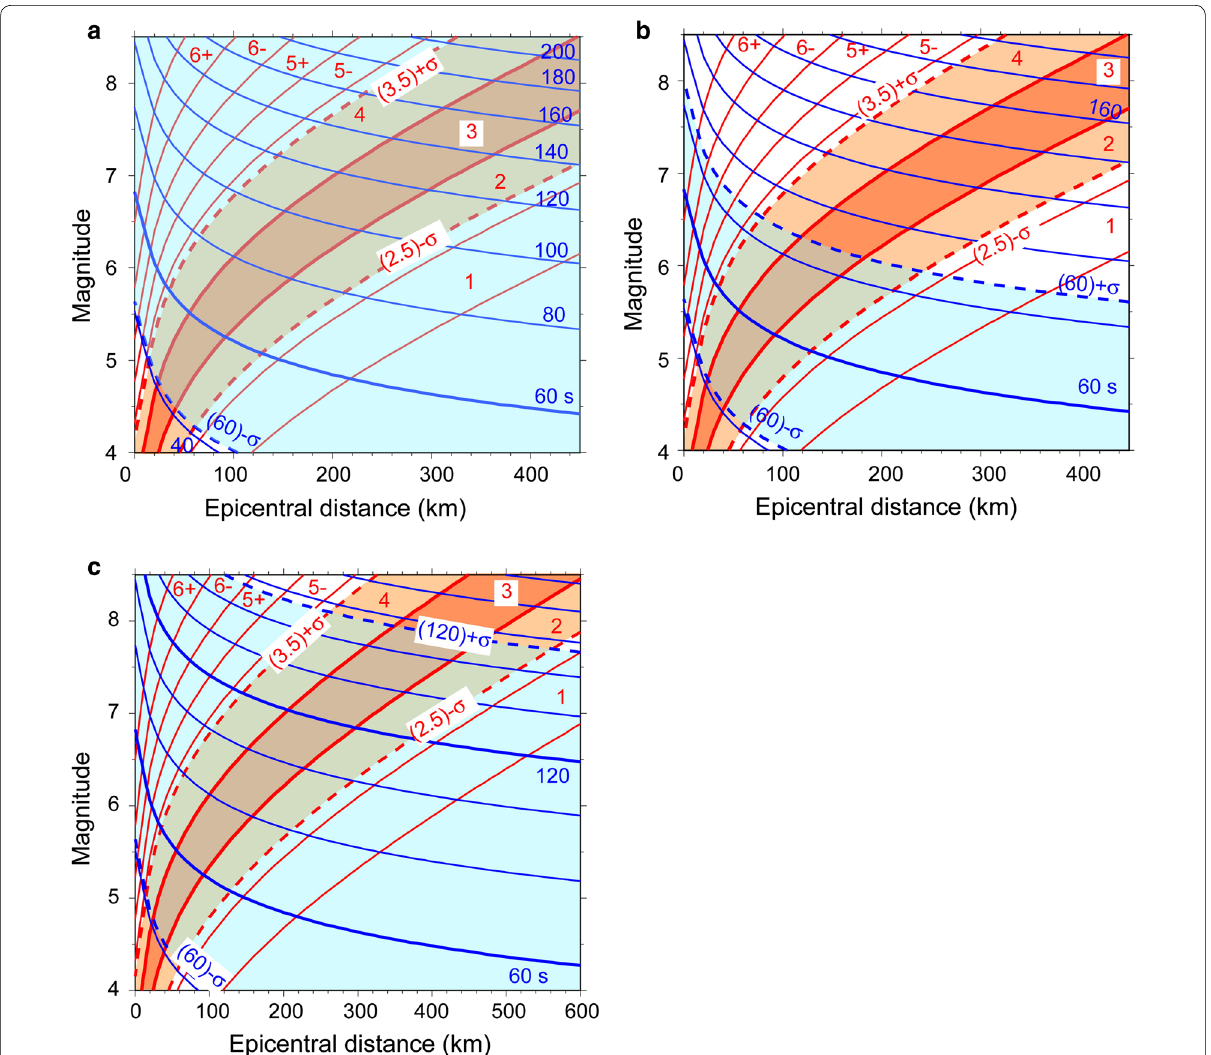
Fig. 3 Duration and seismic intensity as a function of magnitude and epicentral distance. a Earthquake at 2:30 on September 22, 1858. b Earth‑ quake at 20:00 on October 29, 1858. c Earthquake at 15:36 on November 7, 1858. Red lines show the seismic intensity contours; thick solid and dotted red lines highlight the range of seismic intensity 3 and its error bars , respectively. Blue lines show the duration of shaking contours; blue filled area highlights the area where the shaking duration is in the range of the observed value including error